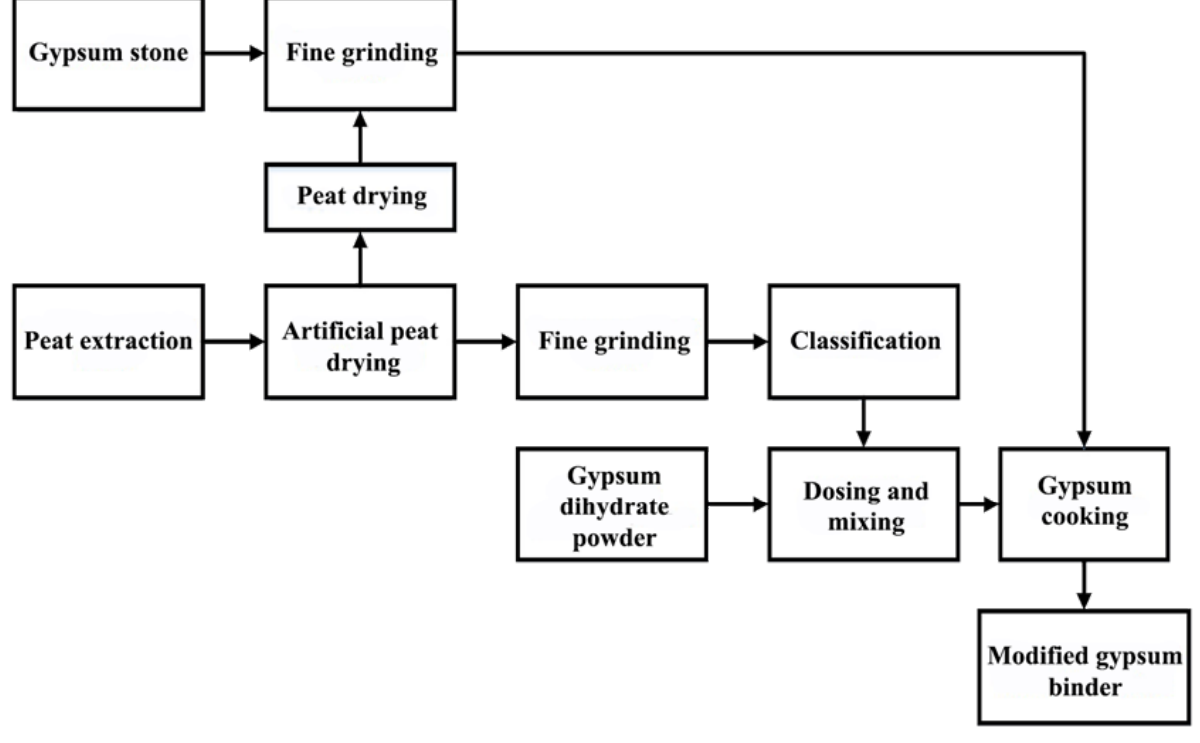
Figure 7. Structural scheme for the production of modified gypsum